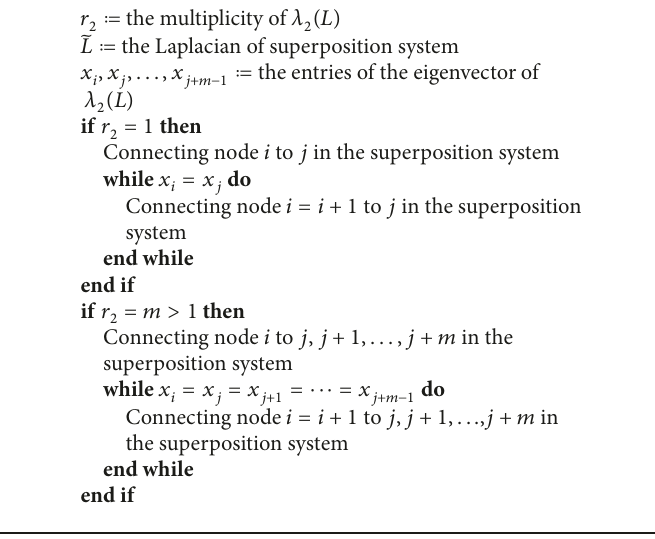
Algorithm 1: Finding a superposition system to enhance the convergence